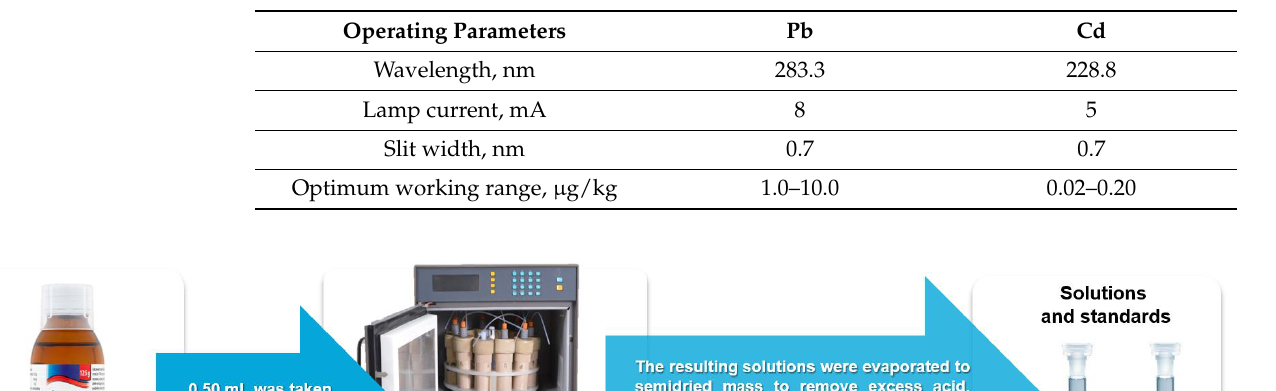
Table 3. The applied instrumental conditions for Pb and Cd determination by ET AAS.